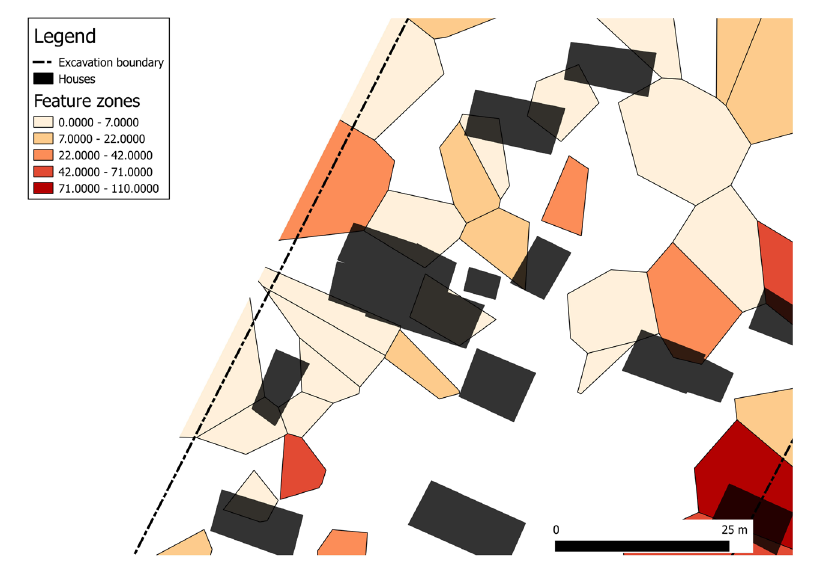
Figure 13: Part of the spatial distribution of the debitage products made on Type 2 limnosilicite. Note the accumulation of the finds north of the building complex in the middle.